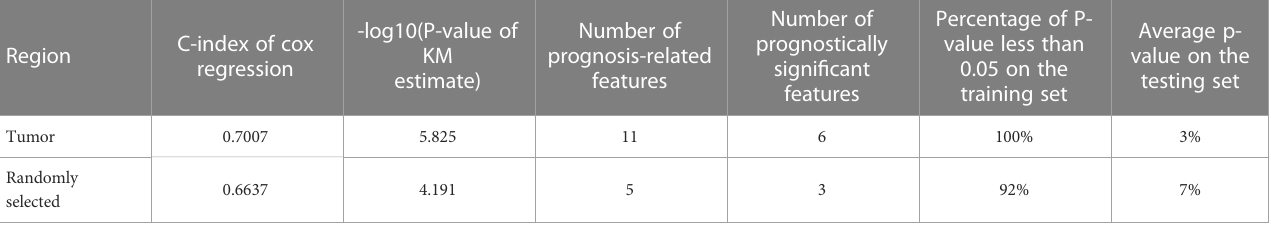
TABLE 3 Comparison of C-index of the cox regression model, -log10(p-value) of survival analysis, the number of prognosis-related features, and the percentage of p-value less than 0.05 on the training and testing set in cross-validation between the prognostic prediction model using morphological features extracted from cells in the tumor region and the model using features in regions randomly selected from the whole slide.